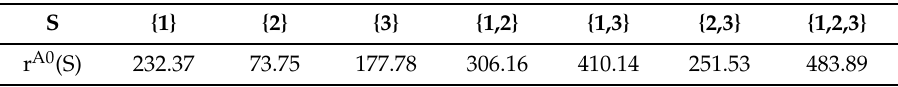
Table 20. The running cost game ({1,2,3},r A0